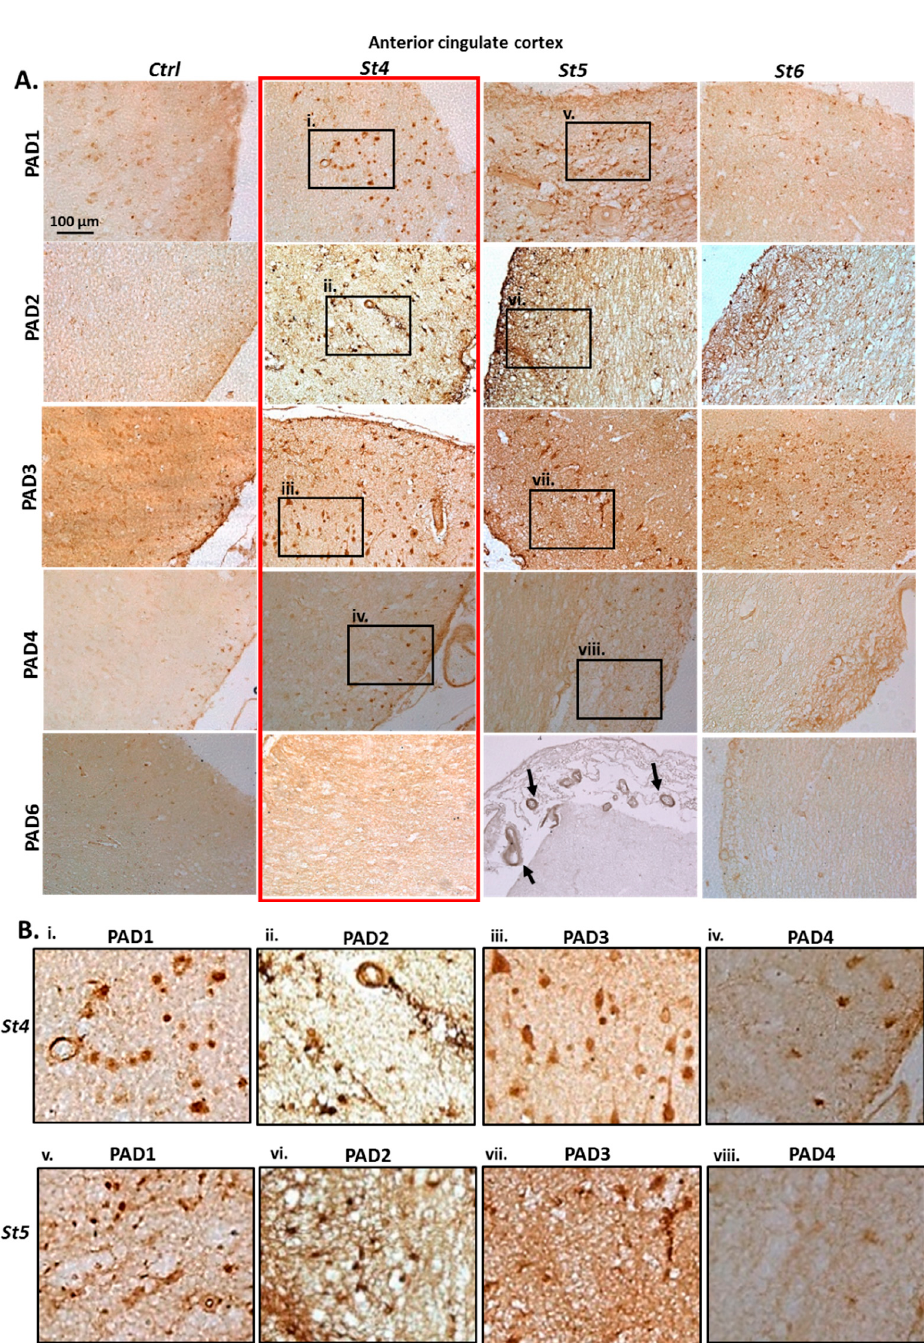
Figure 1. PAD isoform detection in anterior cingulate cortex tissue sections showing